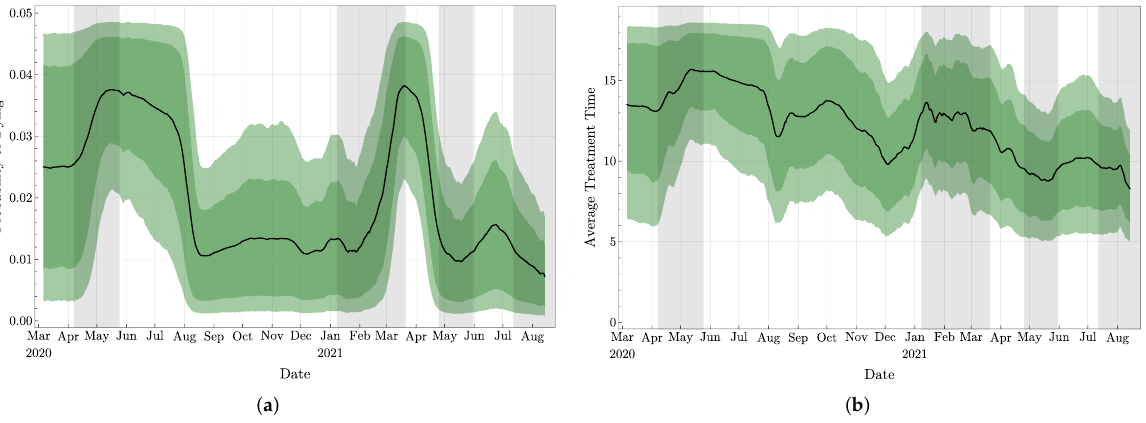
Figure 9. Mean value and 68%, resp. 90%, confidence interval for: ( a ) the probability P d of dying, while in T and ( b ) the expected time E ( τ T ) spent in compartment T